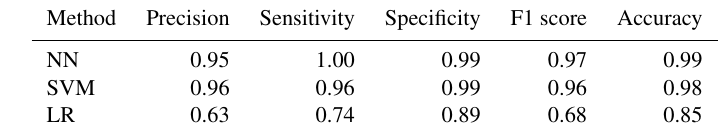
Table 8. Comparison metrics best configuration for drought by method.